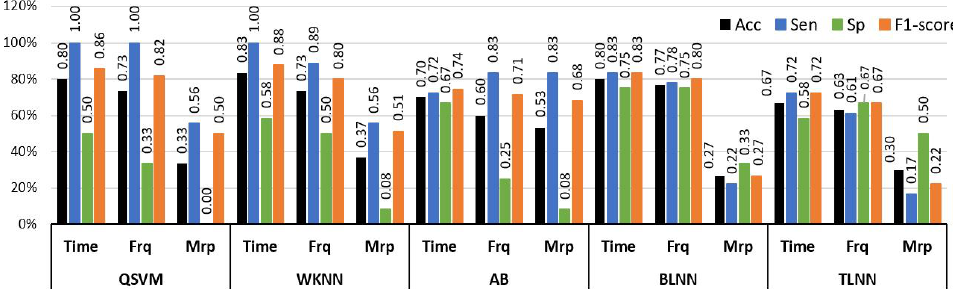
Figure 6. Performance evaluation with time, frequency (Frq), and morphological (Mrp) features using different classifiers for Experiment 1 (no pain vs. high pain). (QSVM: Quadratic-SVM, WKNN: Weighted-KNN, AB: AdaBoost, BLNN: bi-layered neural network, TLNN: tri-layered neural